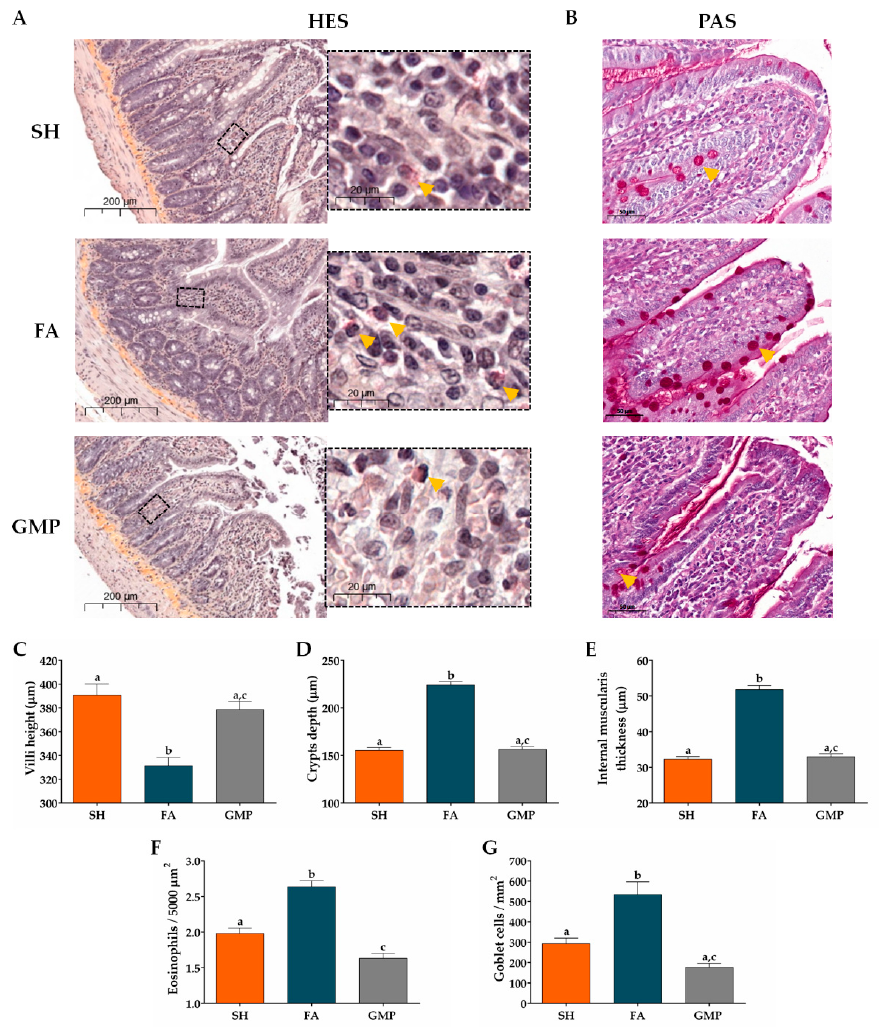
Figure 7. Effect of treatment with glycomacropeptide (GMP) on the pathophysiology of the intestinal mucosa in rats with food allergy (FA). Sections of jejunum were stained with ( A ) hematoxilin-eosin-sa ff ron (HES) to analyze morphological alterations of mucosa and to identify eosinophils (yellow arrows), or with ( B ) Schi ff ’s periodic acid (PAS) to identify goblet cells (yellow arrows). Morphometric analysis was made with the Case Viewer 3D Histech software. The ( C ) villus height ( μ m), ( D ) crypt depth ( µ m), and ( E ) internal muscularis layer thickness ( µ m) were measured in samples of small intestine obtained from experimental animals. Quantitative analysis of ( F ) eosinophils and ( G ) goblet cells in intestinal tissue was developed in fields of 5000- μ m 2 and 1-mm 2 surface, respectively. SH, sham control; FA, FA-induced; GMP, FA-induced and GMP-treated animals. Different letters (a,b,c) indicate statistical difference.